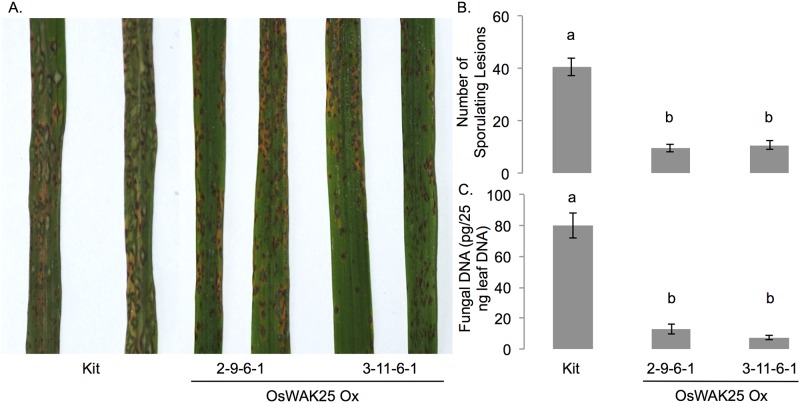
OsWAK25 overexpression confers resistance to Magnaporthe oryzae.Four-week old rice plants were inoculated with the highly virulent strain, VT7. (A & B) Photos were taken and sporulating lesions were counted 6 dpi. (C) Fungal DNA was estimated using a qPCR-based method with primers targeting the 28S ribosomal gene. Different letters represent statistical significance from an ANOVA followed by a Tukey-Kramer significance test. These experiments were conducted twice with data from one representative experiment shown.